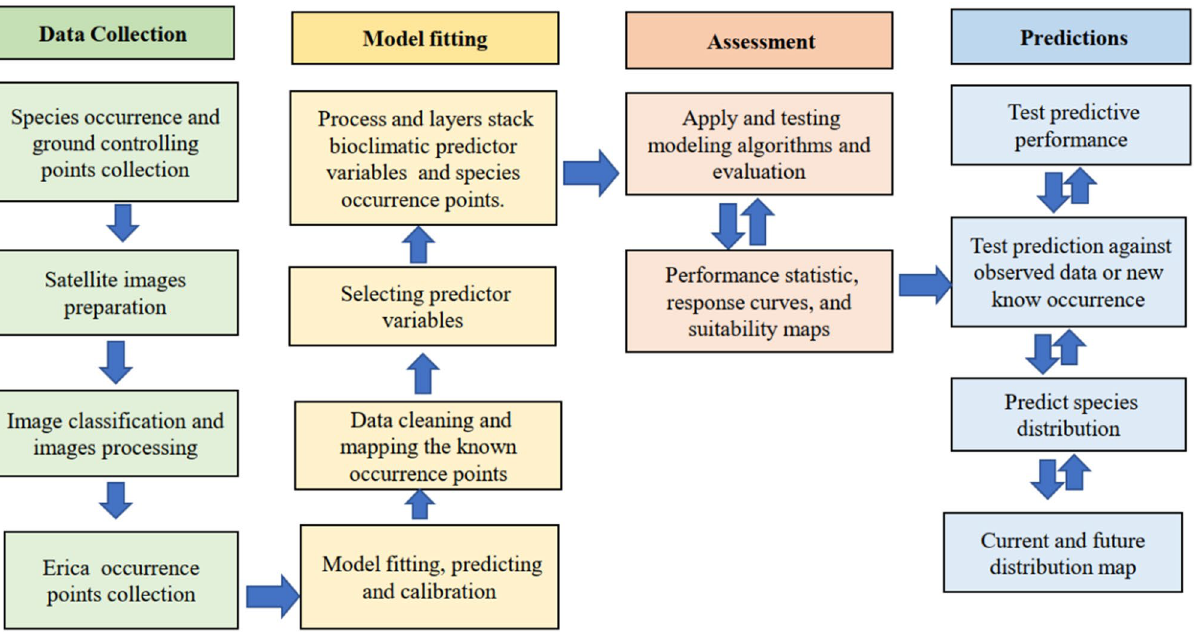
Figure 3. Modeling flow diagram detailing the main data collection and preparation steps, modeling fitting, assessment and evaluation, and prediction and validating Data collection. Ground controlling points collection and data preparation. Landsat TM + 8 remote sens-